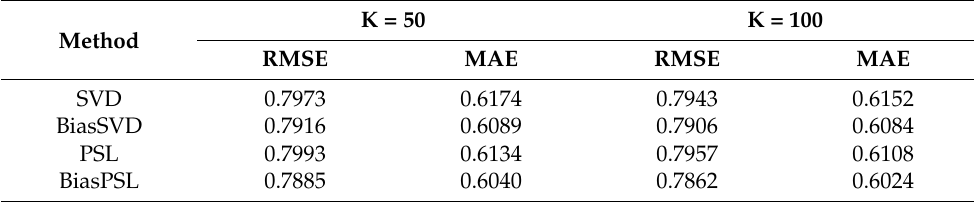
Table 4. The prediction result on MovieLen-10